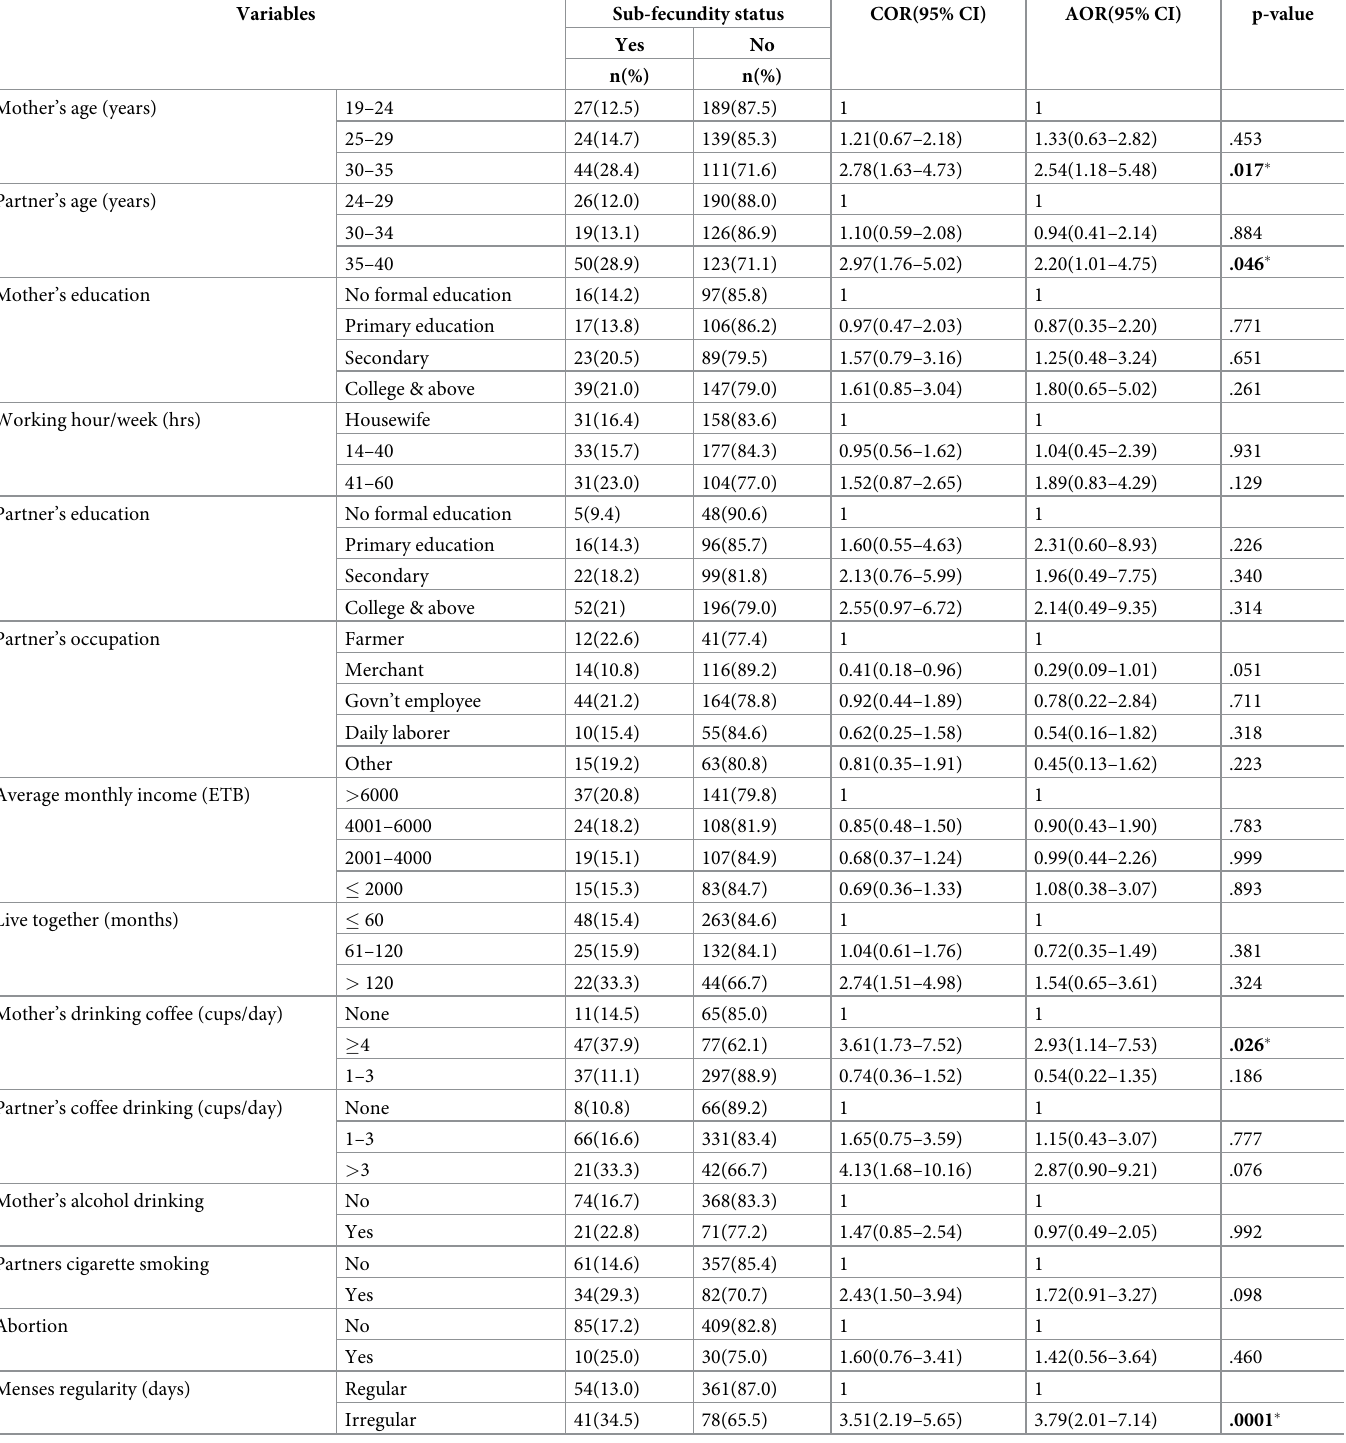
Table 5. Factors associated with sub-fecundity for mothers with natural planned conception attending ANC service at AMHFs,